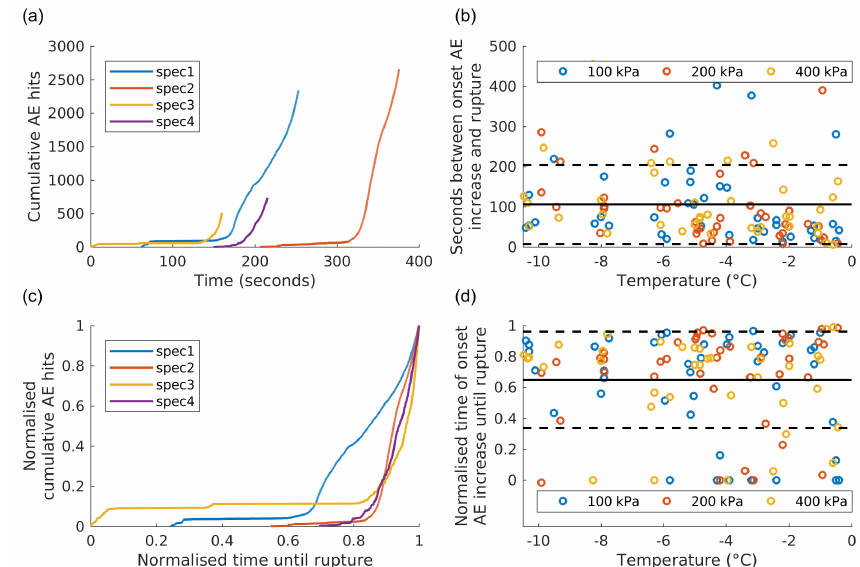
Figure 5. Time series of (a) cumulative AE hits and (c) normalised cumulative AE hits with 400kPa normal stress and at − 4 ◦ C. Time zero corresponds to the shear start of the experiments (spec1–4). Curves starting at x > 0 represent tests in which the first AE signals were recorded a certain time after shear start. The temperature-dependent time between onset of AE increase and rupture is displayed in seconds (b) and normalised (d) . The black lines indicate the overall mean while the dashed lines indicate the standard deviation range. Tests at 800kPa were not considered in (b) and (d) because they were only conducted at temperatures between − 0 . 5 and − 4 ◦